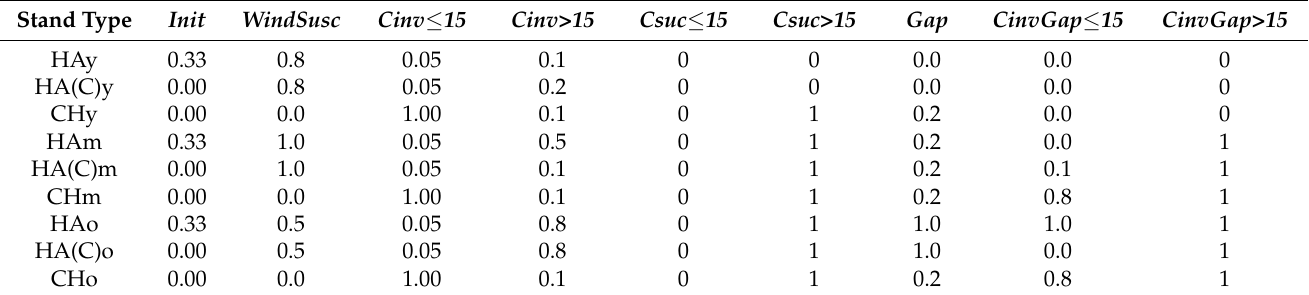
Table 3. Probability values used to define the transitions in the scenario of Clementsian